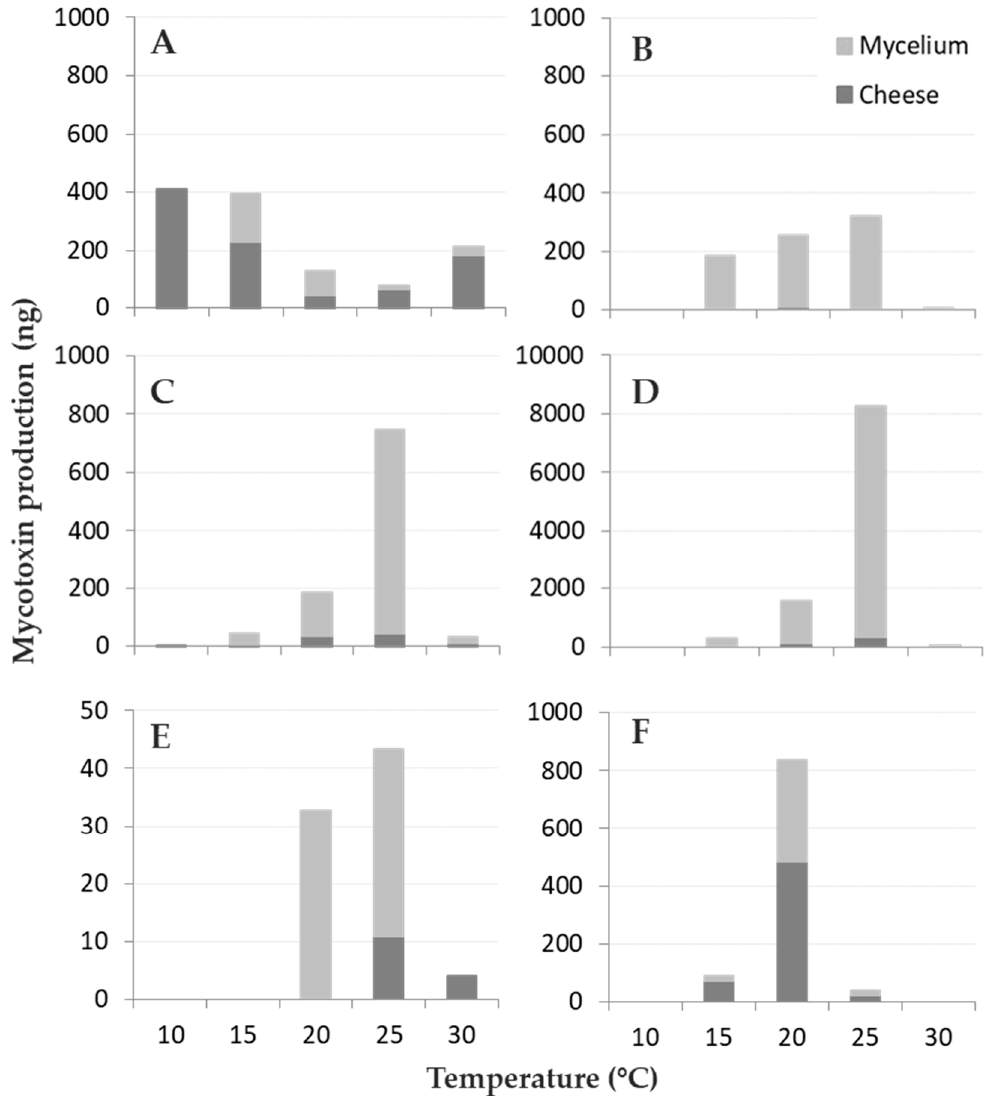
Figure 3. Mycotoxin (ng) partitioning between cheese rind and fungal mycelium for the fungi considered at different temperature levels (10–30 °C, step 5 °C): ( A ) sterigmatocystin (STC)– Aspergillus versicolor , ( B ) penitrem A (PA)– Penicillium crustosum , ( C ) roquefortine C (ROQ-C)– P. roqueforti , ( D ) ROQ-C– P. crustosum ( E ) ochratoxin A (OTA)– P. nordicum and ( F ) OTA– P. verrucosum . The amount of mycotoxin detected in cheese rind is reported in dark grey, while the pale grey part of the bars represents the number of mycotoxins detected in fungal mycelium.